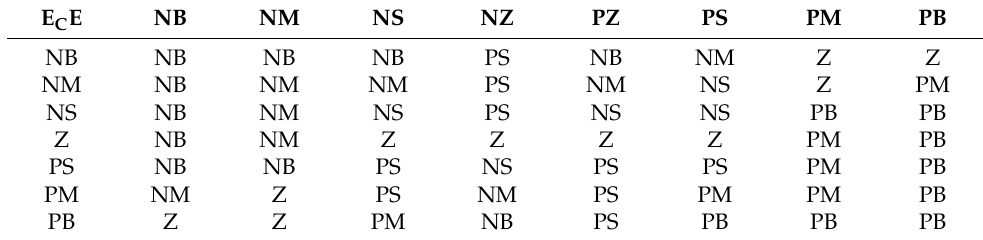
Table 2. Fuzzy control rule for ∆ K P .